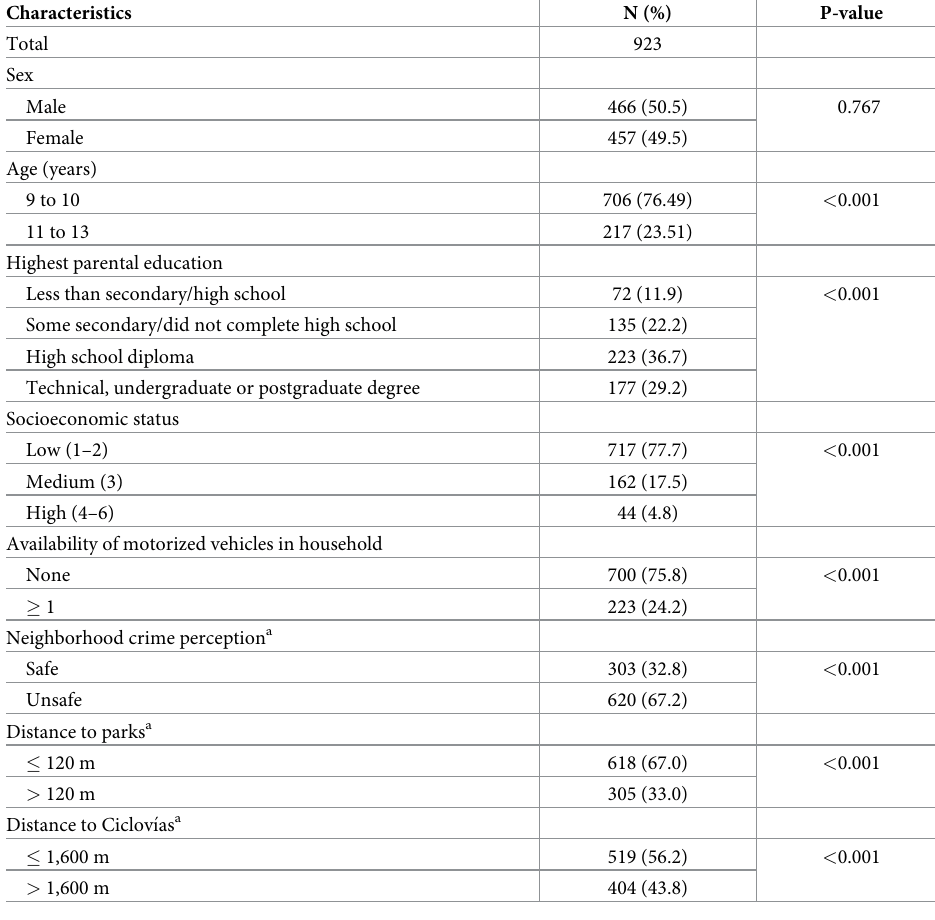
Table 1. Sociodemographic characteristics of participants of analytical sample of the study.